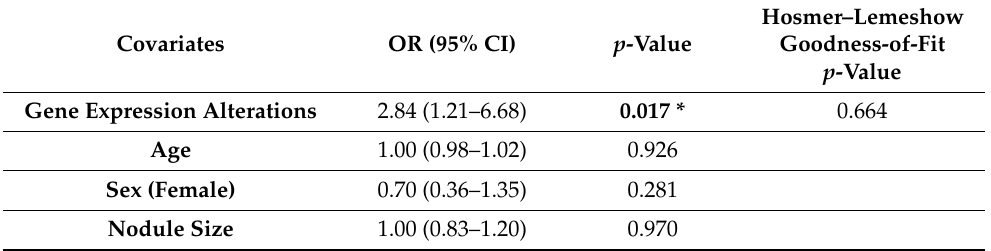
Table 2. Binomial Logistic Regression of Association between Covariates and Malignancy.